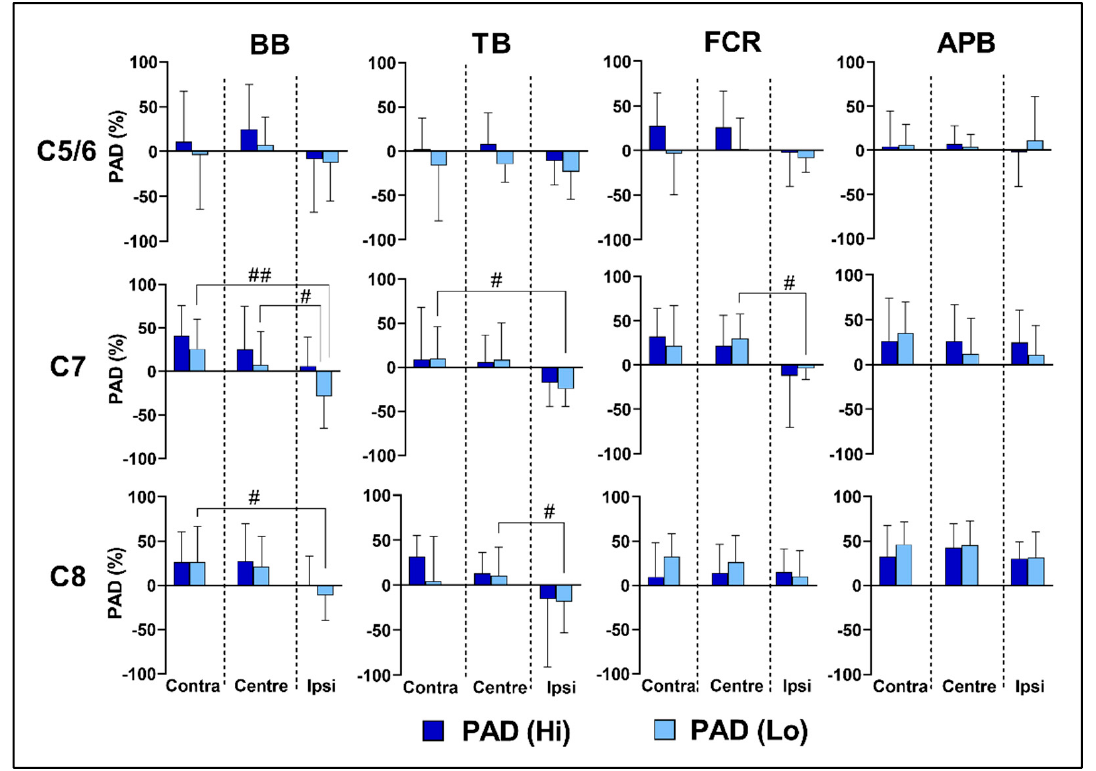
Figure 4. Group mean ± SD PAD across spinal levels (C5, C7 and C8), locations (contralateral, central and ipsilateral) and intensities (Hi = dark blue; Lo = light blue) in BB, TB, FCR and ABP. Note that negative data infer potentiation rather than depression of PRMR 2 . Hash symbols infer significantly lower PAD response at ipsilateral stimulus location (# p < 0.05; ## p < 0.01).